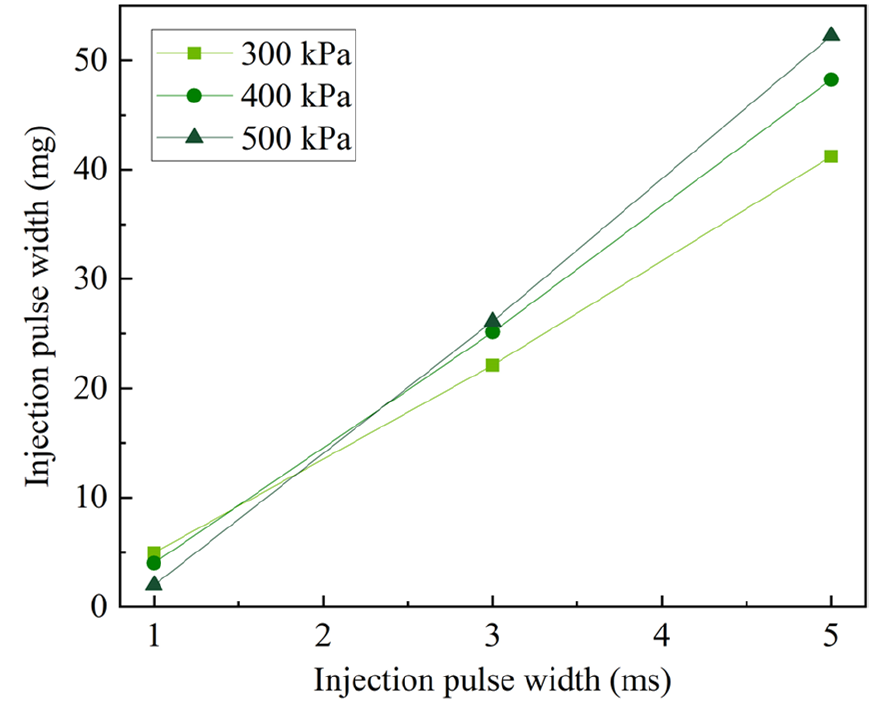
Figure 2. Injector flow characteristics.